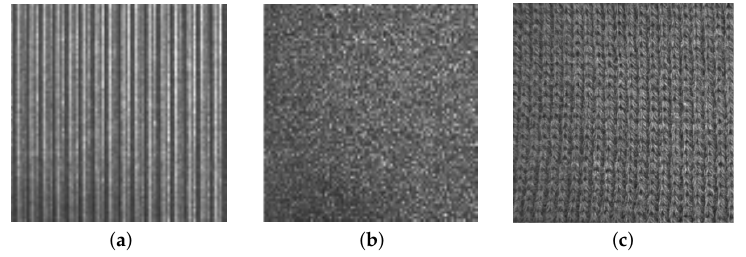
Figure 3. Some homogeneous textures: ( a ) structural texture with directional pattern; ( b ) isotropic statistical texture; ( c ) isotropic patterned texture.